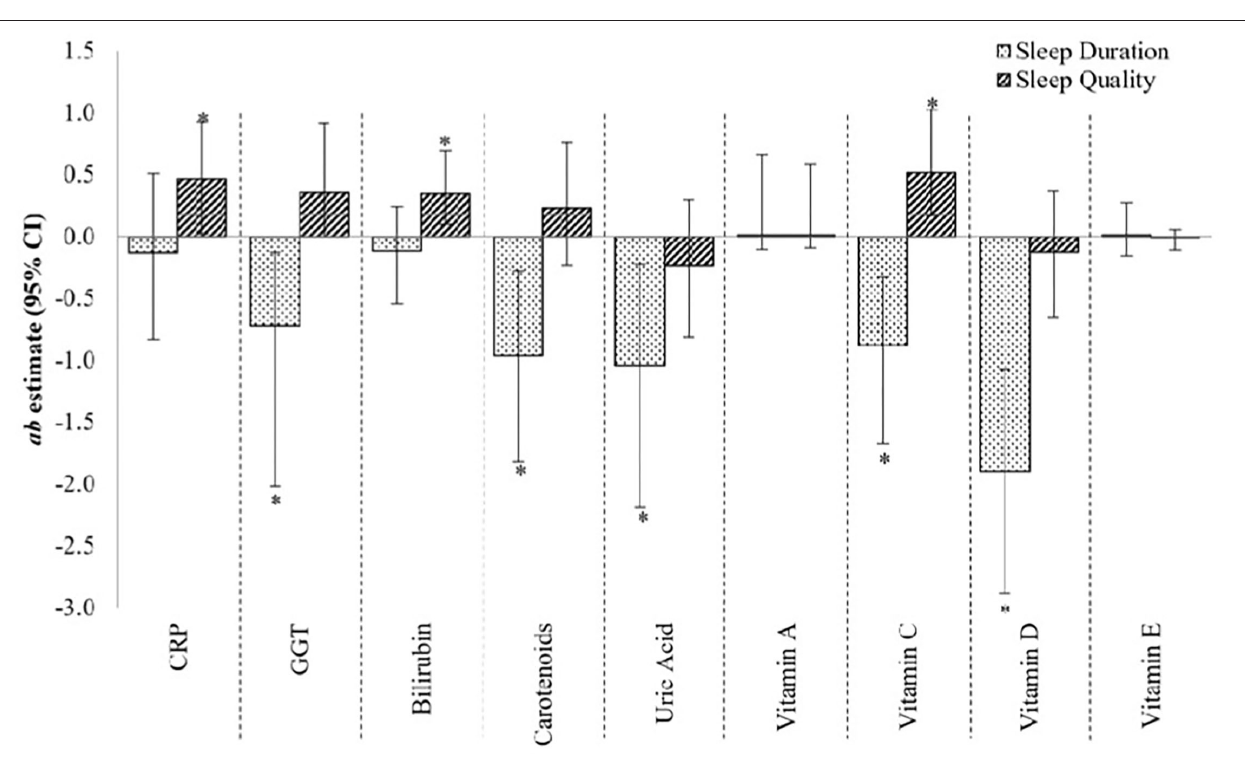
FIGURE 2 | The contribution of CRP, GGT and micronutrient antioxidants to the sleep–fasting insulin concentration relationship. ab estimate, amount of mediation, or contribution by the mediatory variable (moderate effect when ab ≥ 0.09, and large effect when ab ≥ 0.25); CI, confidence interval. *p < 0.05, 95% CI are bias-corrected, bootstrapped values. Each mediator was tested one-by-one in the mediation